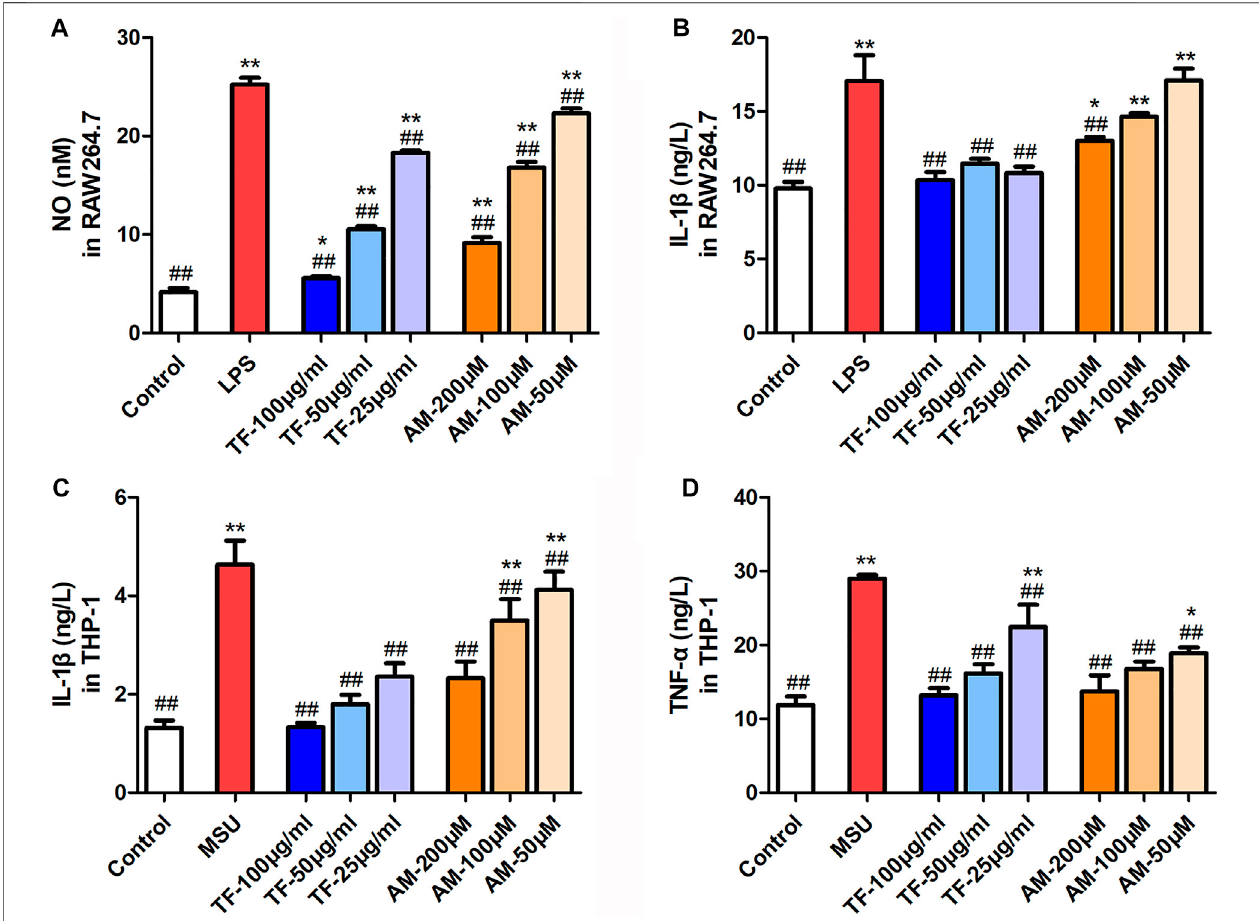
Frontiers in Pharmacology |